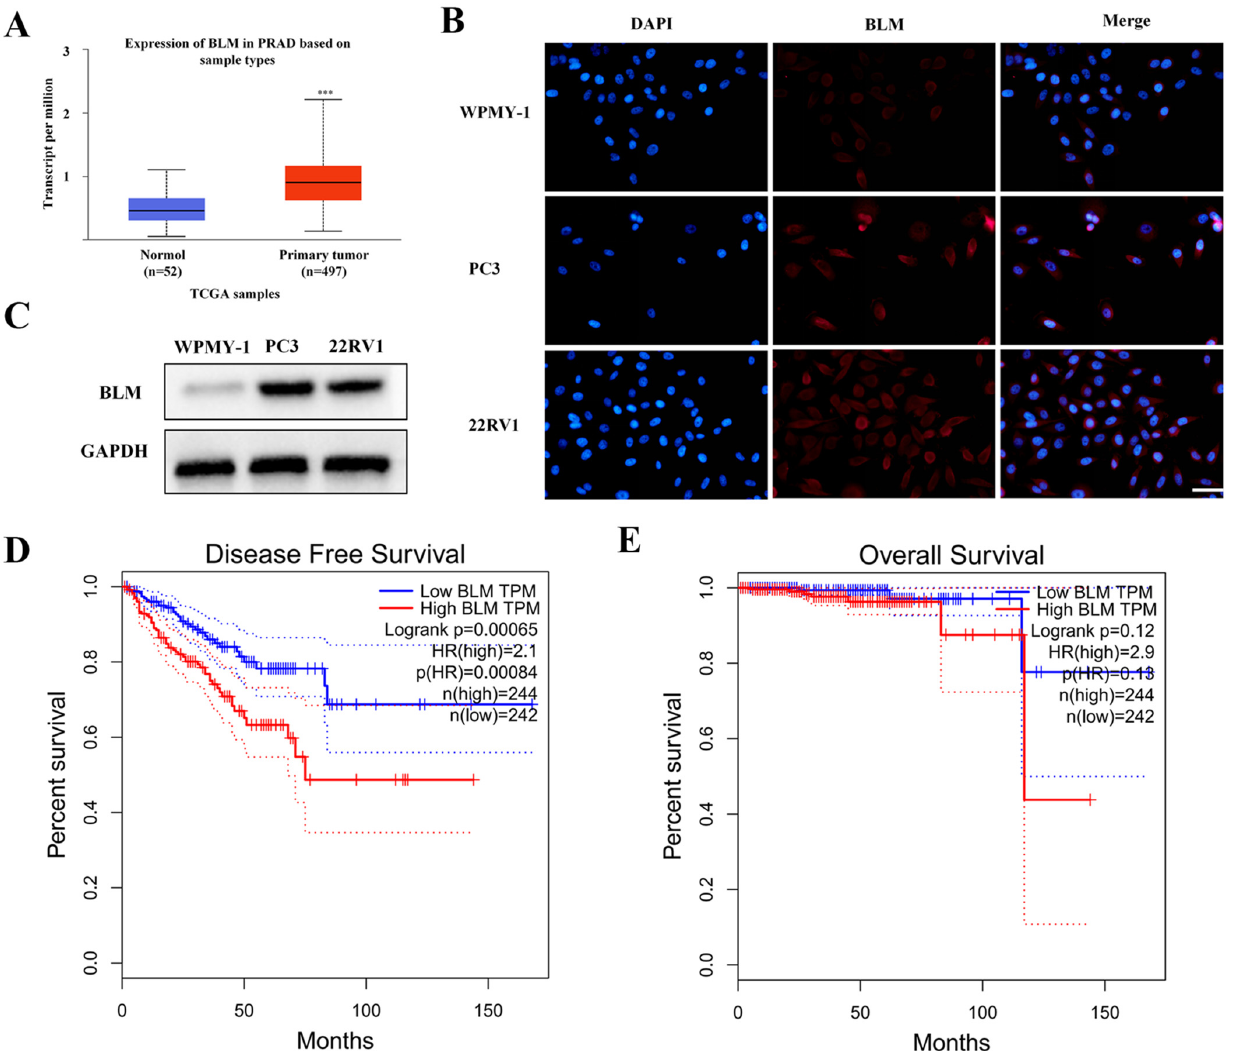
Figure 1. Expression of BLM in PCa. ( A ) In the TCGA database, the expression of BLM transcripts ( n = 497) was significantly higher than that of normal tissue ( n = 52) in PCa (*** p < 0.001). ( B ) The western blotting was used to analyze BLM protein expression levels in PCa cell lines. ( C ) The IF was used to analyze BLM protein levels in PCa cell lines. Scale bars: 50 μ m. ( D ) The comparison of DFS between the high BLM expression group ( n = 244) and low BLM expression group ( n = 242) ( p = 0.00065); n : the number of patients. ( E ) Comparison of overall survival in the indicated groups ( p > 0.05).